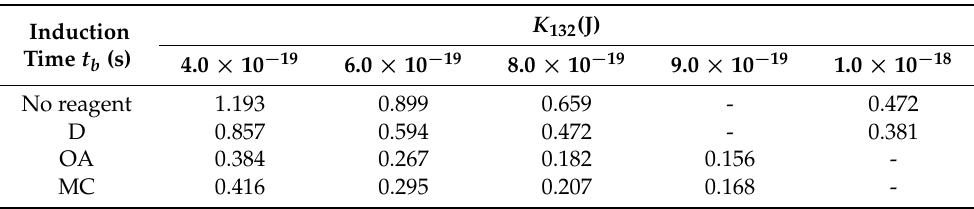
Table 5. Hydrophobic force constant between air bubbles and coal particles treated with different reagents. Table 4. The calculation value of induction time t b corresponding to different hydrophobic force constants. Reagent